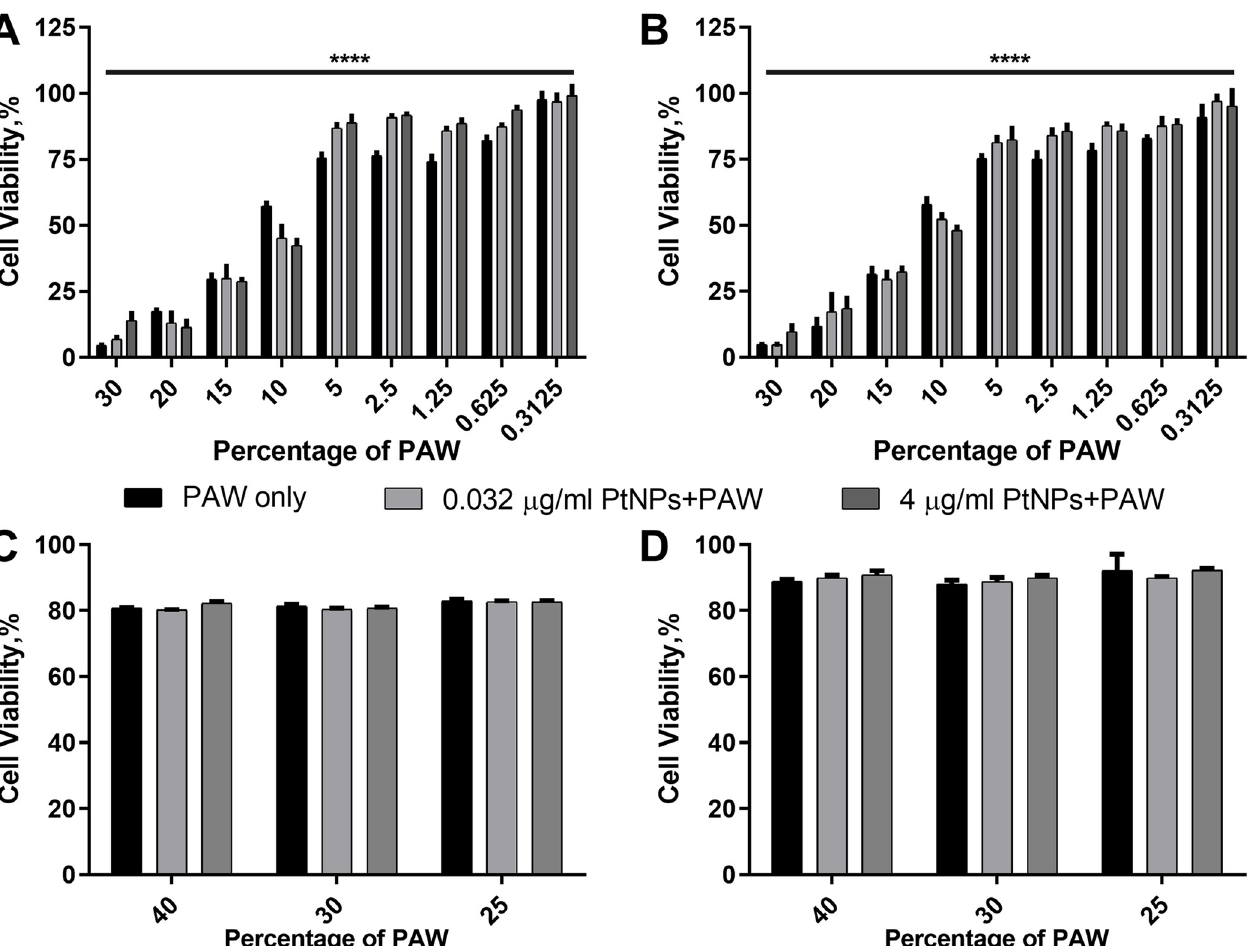
Fig 4. Dose responses for simultaneous PAW treatment. U-251 MG cells were treated with 0.032 and 4 μ g/ml PtNPs and increasing concentrations (0 � 30%) of PAW simultaneously and incubated for 24h (A) or 48 h (B) . 0.032 and 4 μ g/ml PtNPs and 25, 30, 40% of PAW were mixed at incubated at 37˚C for 24 h, U-251 MG cells were treated the mixture and incubated for 24 h (C) or 48 h (D) .